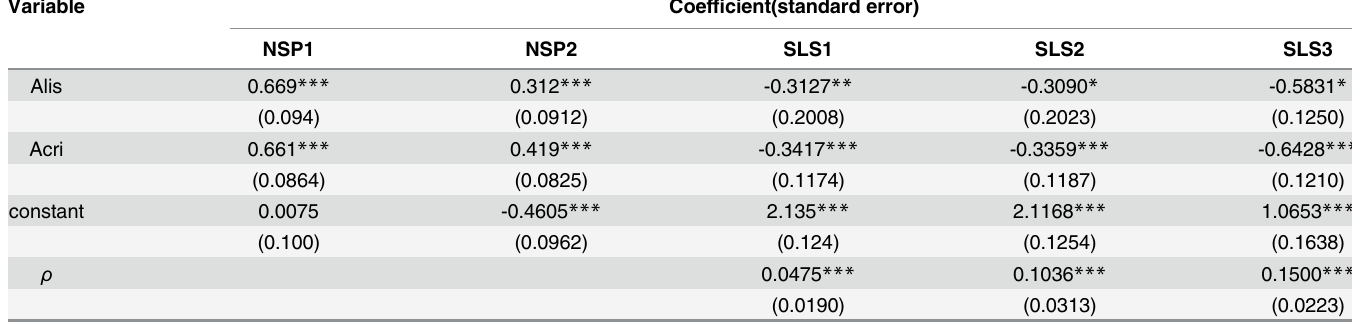
b b form and the estimated coef fi cient of the variable in quadratic form. APEs for a variable k 2 without its quadratic form are obtained by setting